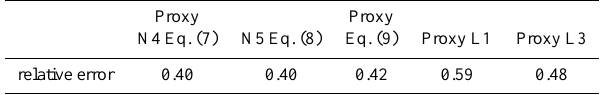
Table 8. Relative erros of the proxies.